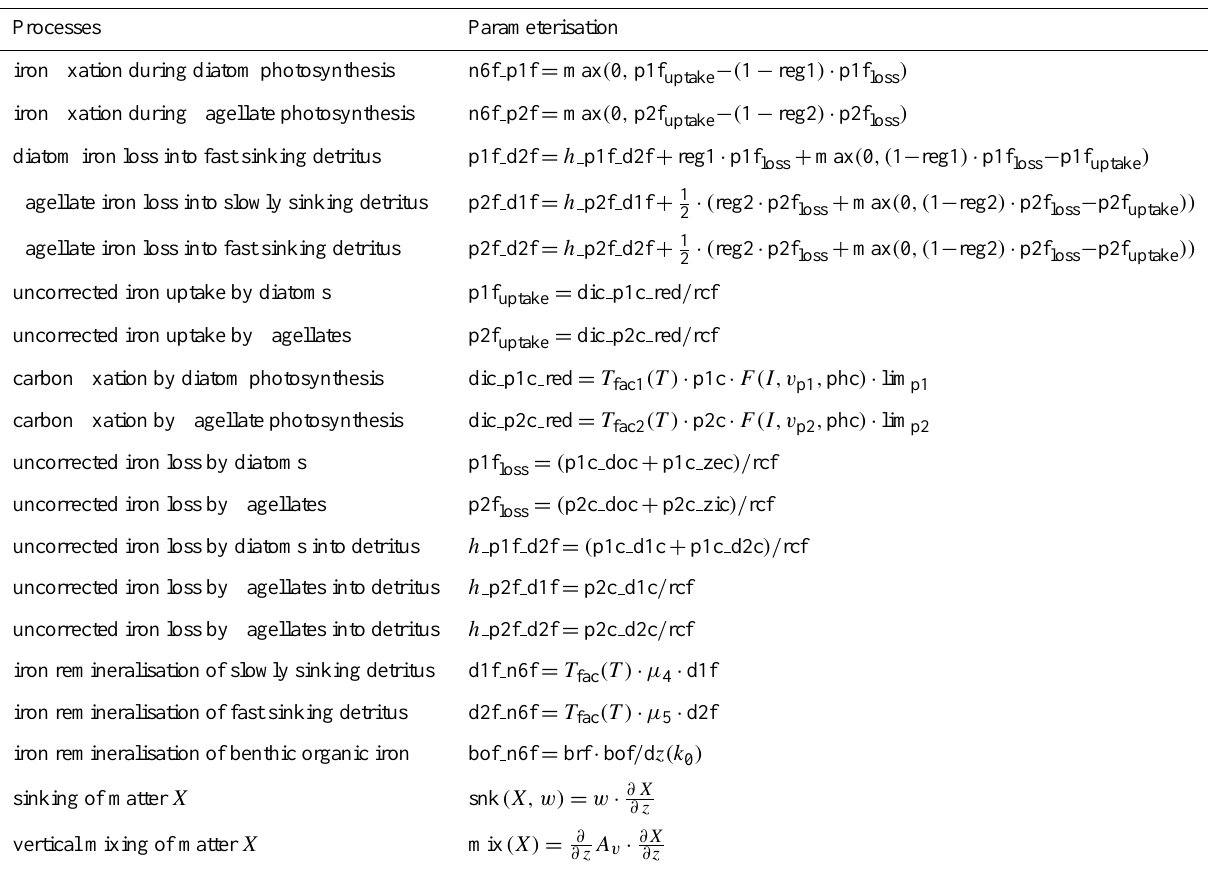
Table A3. Processes taken into account in the conservation equations; p1c – diatom carbon, p2c – flagellate carbon, phc – total phytoplankton carbon, dic – dissolved inorganic carbon, T – temperature ( ◦ C); grazing (pic zxc) as defined in Lorkowski et al. (2012), with changed ingestion